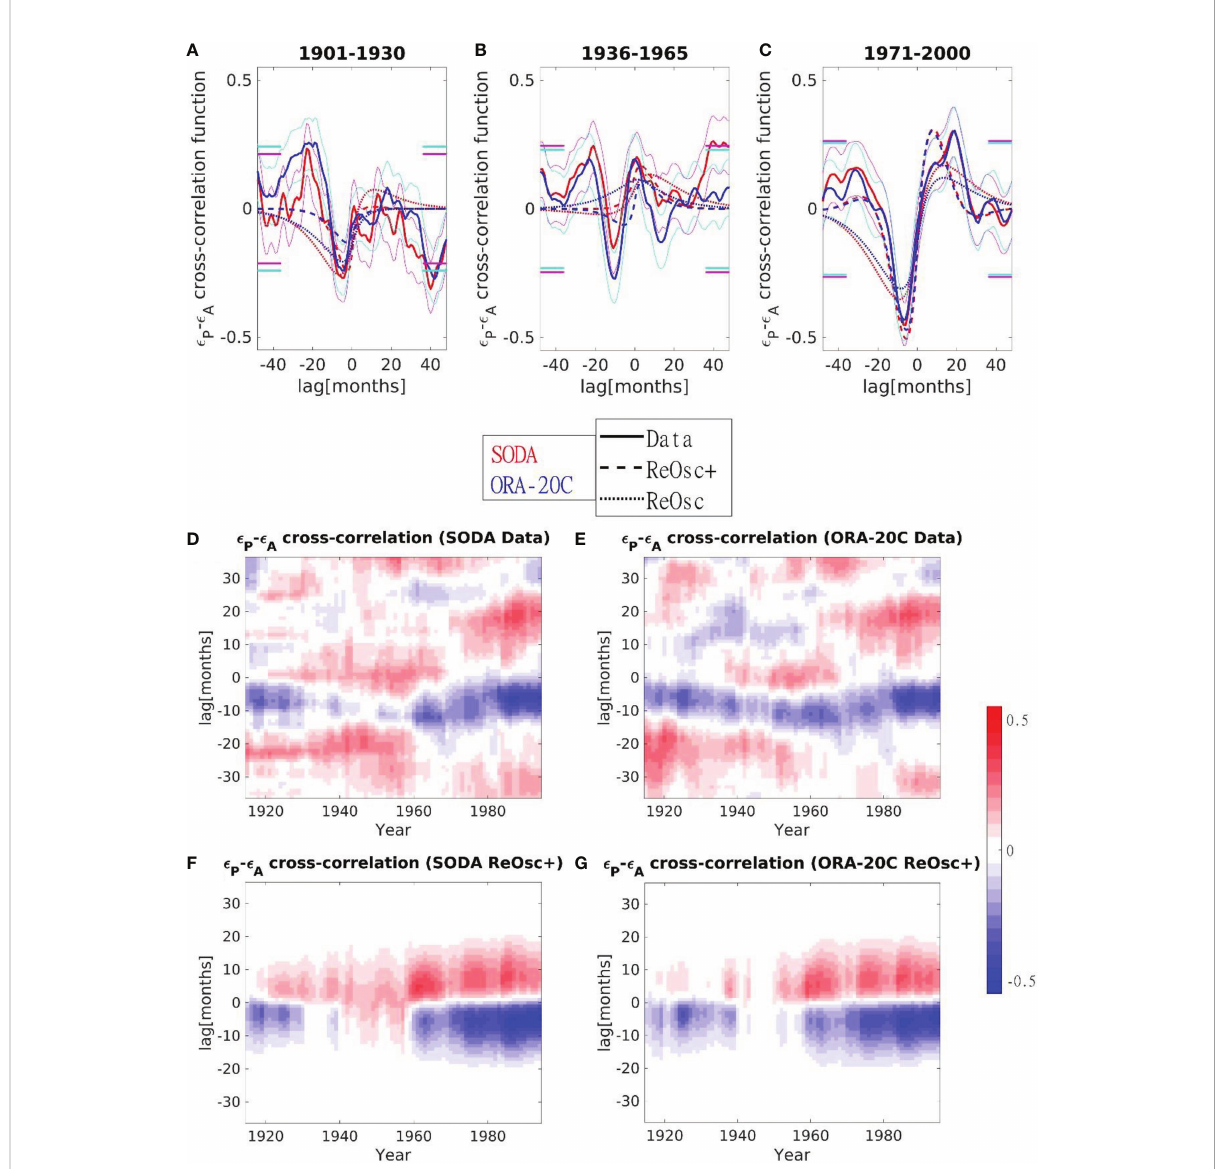
FIGURE 5 Normalized cross-correlation functions, c N PA , between the Paci fi c SST and the Atlantic SST anomalies for the periods 1901-1930 (A) , 1936-1965 (B) , and 1971-2000 (C) , represented for SODA (solid red line) and ORA-20C (solid blue line, mean of all members) data, ReOsc+ model (dashed line) and ReOsc model (dotted line) for the two-variable Paci fi c-Atlantic dynamics (Eq. 8 fi tted as explained in Section 2.3). Magenta (for SODA) and cyan (for ORA-20C) thin lines show the 95% con fi dence interval of the data crosscorrelation (see Supplementary Appendixes A, D). Magenta (for SODA) and cyan (mean of all members for ORA-20C) thick lines show the uncertainty in correlation beyond 36 months, i.e., solid lines inside those limits indicate that there are no signi fi cant contributions from the correlations beyond 36 months (see Supplementary Appendix B). ( D – G ) Color map of the normalized cross- correlation function for SODA (period 1900-2008) and ORA-20C (period 1900-2009, mean of all members) reanalysis, both for the data ( D , E , respectively) and for the ReOsc+ model ( F , G , respectively). Each column represents the function for a time window of 30 years, and the represented year in the horizontal axis is the mean value of that interval. The vertical axis indicates the lag in the cross-correlation function (if positive, Paci fi c leads). Red Blue Colormap (Auton, 2022) was used in (D – G) of this fi